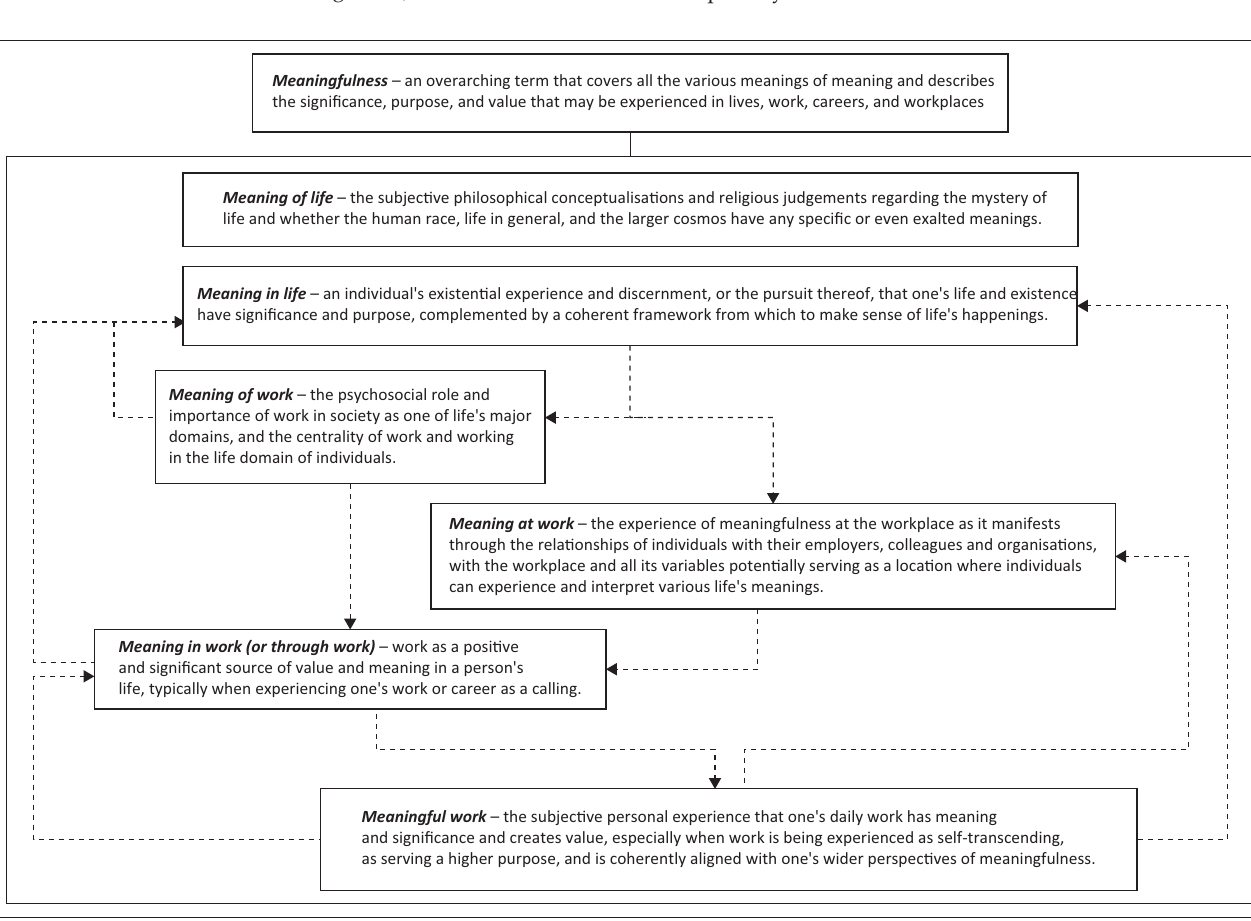
FIGURE 1: Lexicon of the meanings of